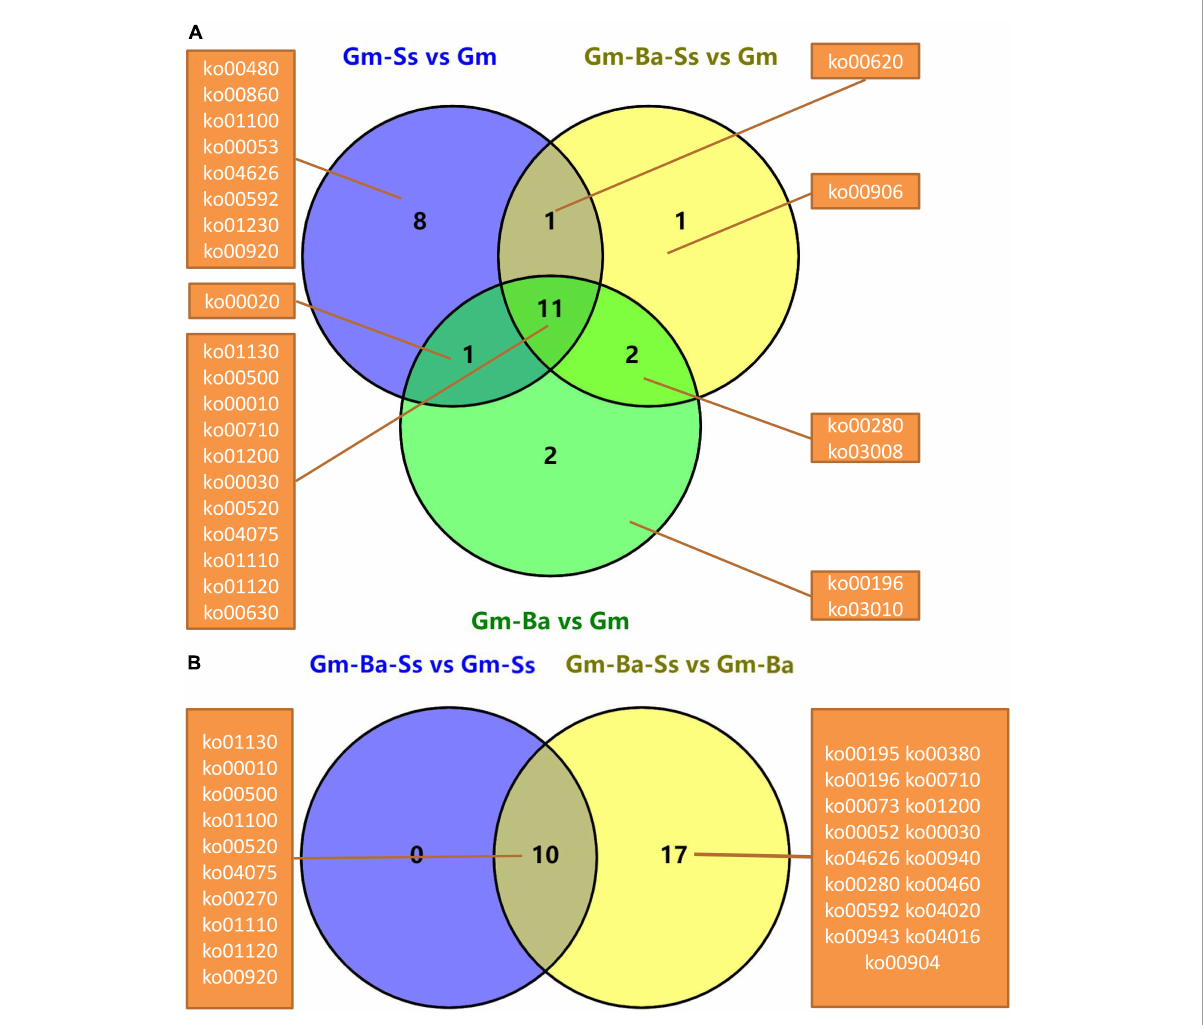
FIGURE5 Venn diagrams of significantly enriched KEGG pathway. (A) Venn diagrams of significantly enriched KEGG pathway from three pairwise comparisons of Gm-Ba vs. Gm, Gm-Ba-Ss vs. Gm, Gm-Ss vs. Gm. (B) Venn diagrams of significantly enriched KEGG pathway from two